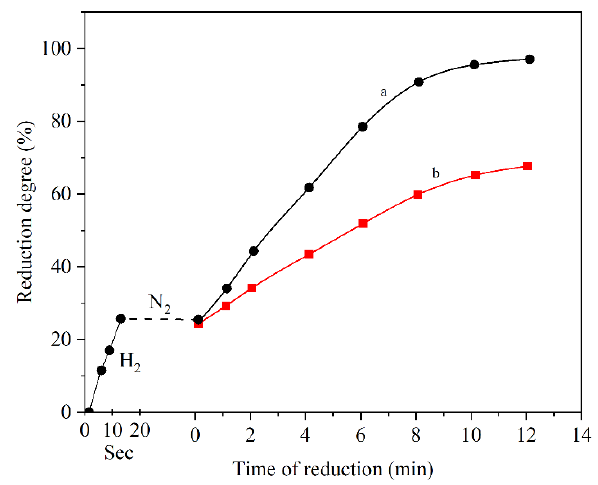
Figure 6. Reduction of wüstite at 1000 °C in ( a ) H 2 followed by CO; ( b ) pure CO [36] “modified”.